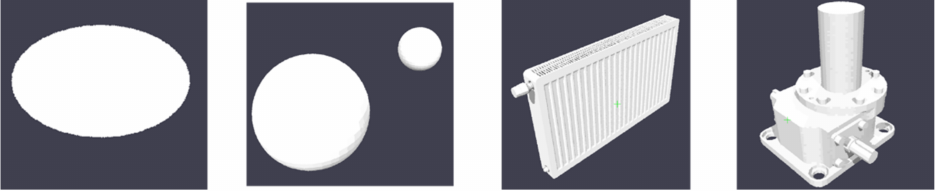
Figure 8. Surfaces created by using multiple polygons. All the surfaces shown above were first modeled in Sketchup ® and then exported into the RADIANCE format using the plugin